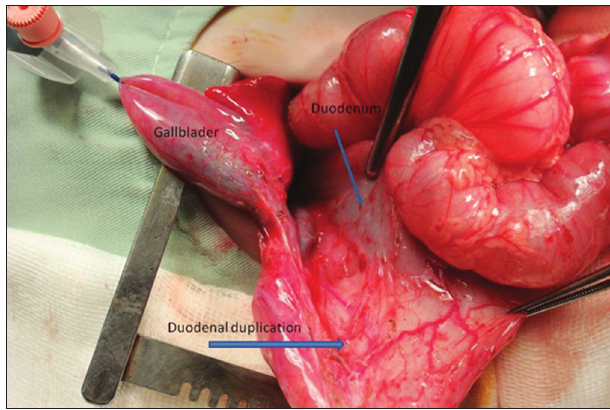
Figure 2: Duplication cyst sharing common wall with duodenum